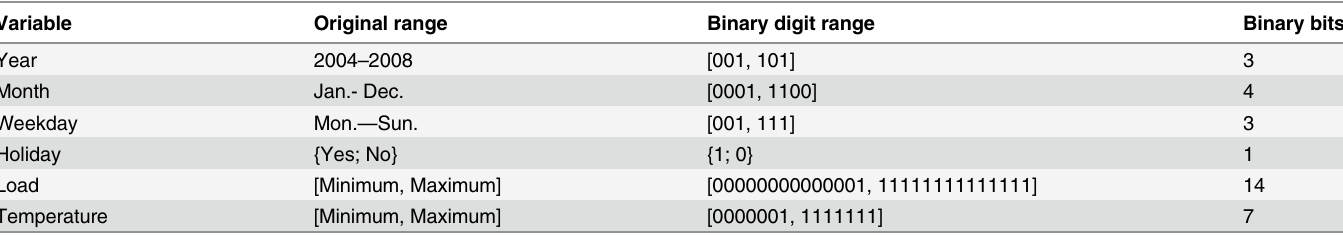
Table 1. Variables and their binary